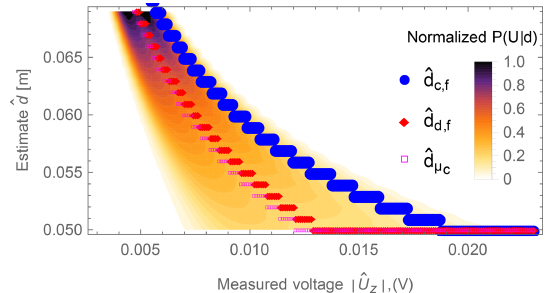
Figure 11. Mapping of the measured voltage | ˆ U Z | to the estimated distance ˆ d for the table-based estimators ˆ d c , f , ˆ d d , f and ˆ d µ with the normalized voltage probability distribution P ( U | d ) at any given distance d .